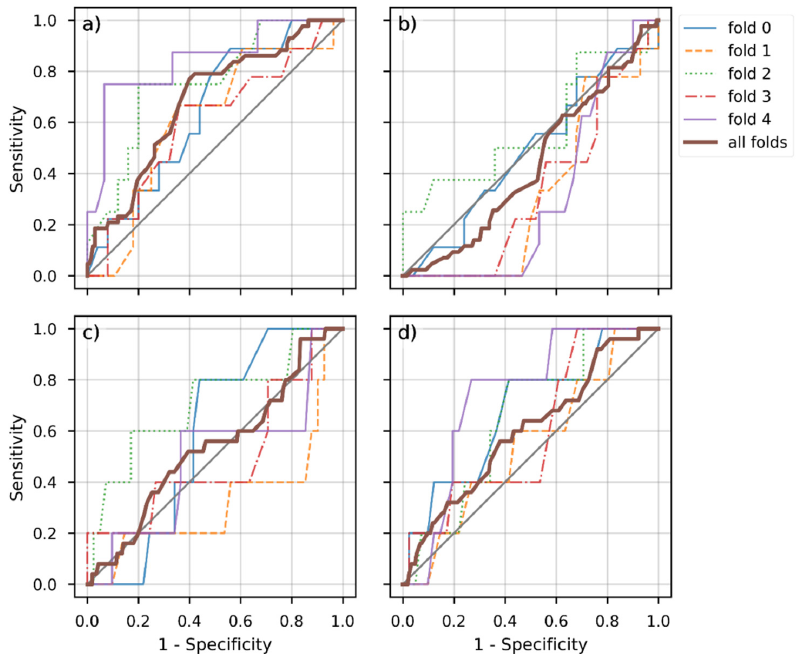
Figure 3. Receiver operator characteristic (ROC) of all obtained models (i.e., folds) and combination of input data for the training ( a , b ) and external validation dataset ( c , d ). ( a , b ) depict ROC curves for the training cohort: ( a ) using only T2w images as input vs. ( b ) using T2w and DW images as input. ( c , d ) depict the corresponding results for the external validation dataset: ( c ) using only T2w images as input vs. ( d ) using T2w and DW images as input. In each panel, the bold brown-colored curve depicts the average over the five folds.